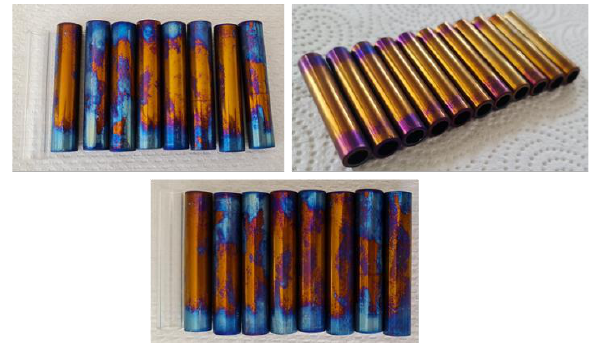
Figure 14. Raschig rings after heat treatment.